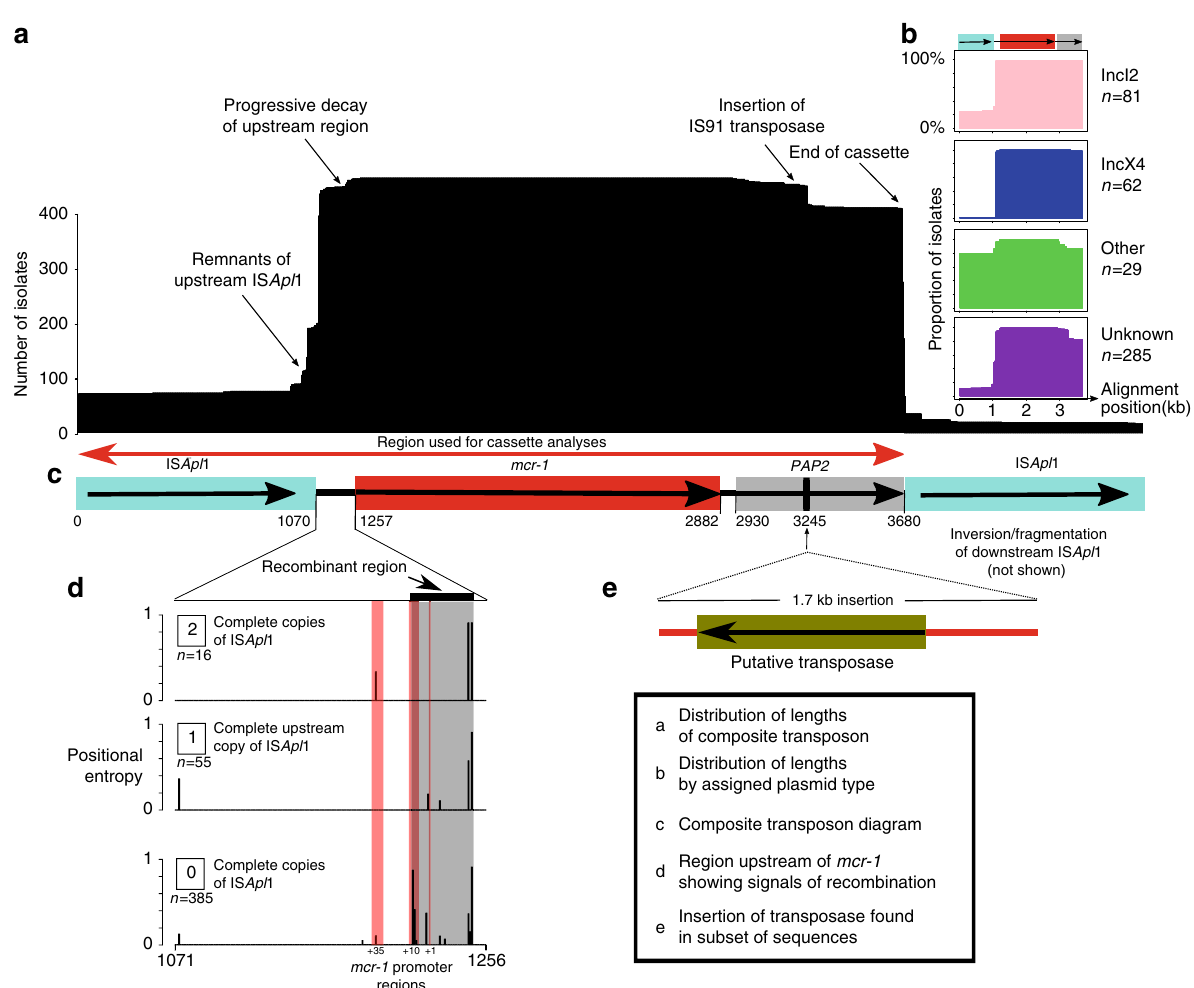
Fig. 3 The genetic element carrying mcr-1 is a composite transposon and is alignable across our global data set. a Length distribution of the alignment across sequences. b Length distribution subset by plasmid type. c The composite transposon, consisting of IS Apl1 , mcr-1 , a PAP2 orf , and IS Apl1 . The region indicated by the red arrow was used in phylogenetic analyses, after the removal of recombination. d The 186 bp region upstream of mcr-1 showed strong signals of recombination (gray box) that coincided with the promotor regions of mcr-1 (red box), and this diverse region was removed from the subsequent alignment. e Twenty-eight sequences from Vietnam had a 1.7 kb insertion containing a putative transpose, suggesting subsequent rearrangement